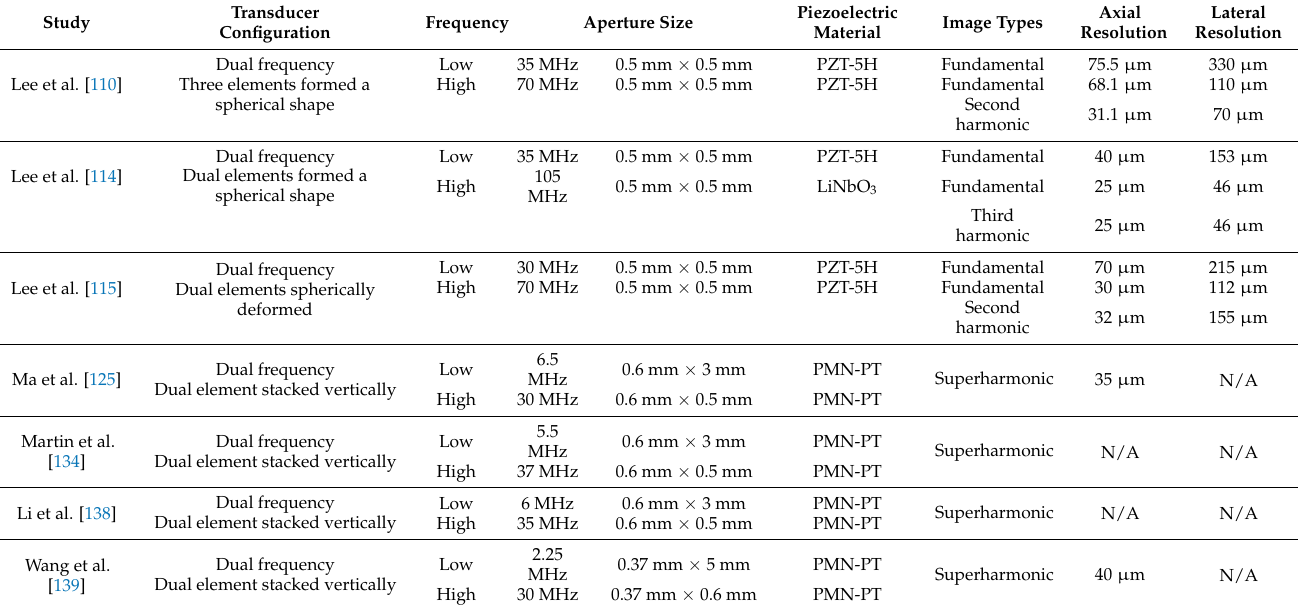
Table 7. A comparison of IVUS harmonic image resolution with that of fundamental